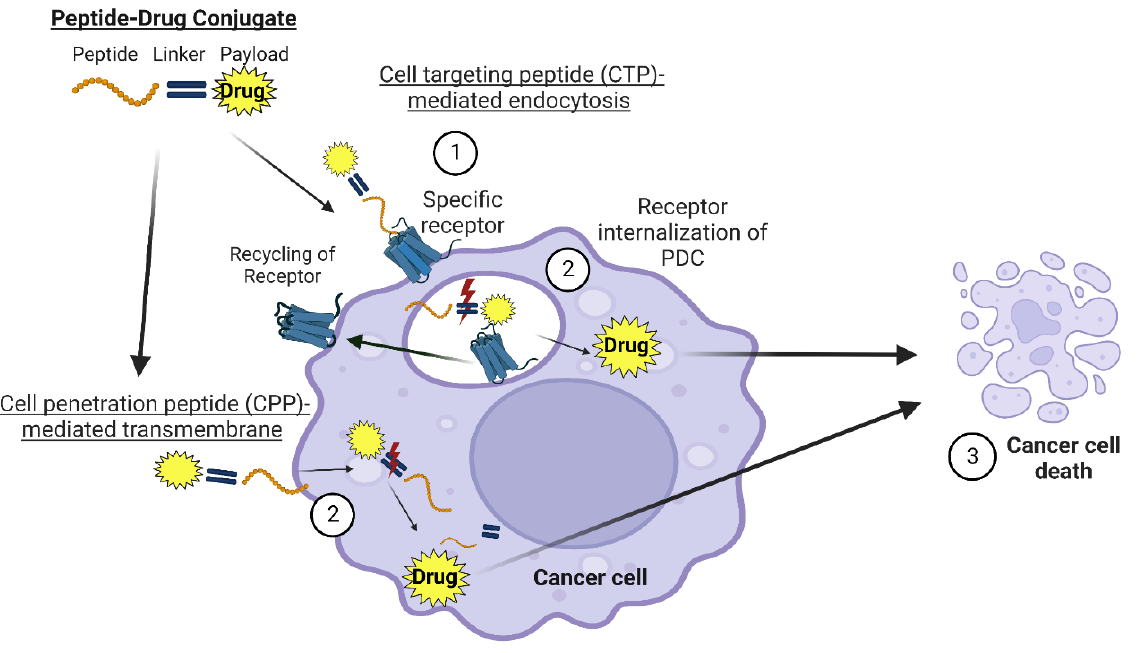
Figure 3. Theoretical summary of the steps that lead to the internalization of the specific (overex- pressed receptor) within cancer cells. Step 1 involves the recognition of the PDC by the receptor. Once the PDC is internalized, the drug is released (Step 2). Note: The red lightning bolt depicts the release of the drug. The receptors are separated from the ligand and can be recycled back to the cell membrane. Cleavage of the linker results in drug release and subsequent cancer cell death (Step 3). This figure was created using BioRender software and license.